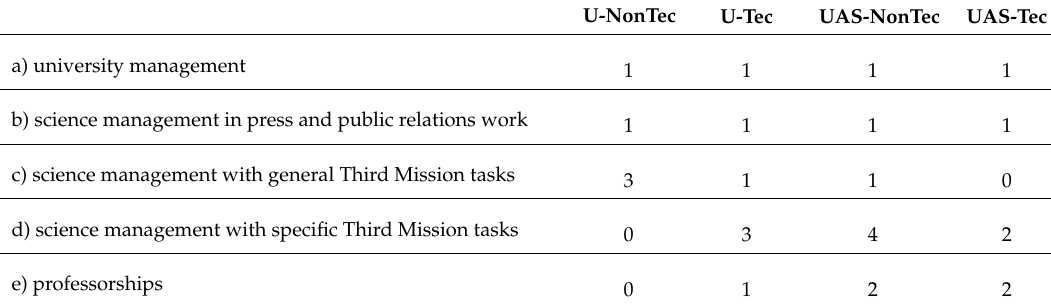
Table 3. Number of interviews per case and actor